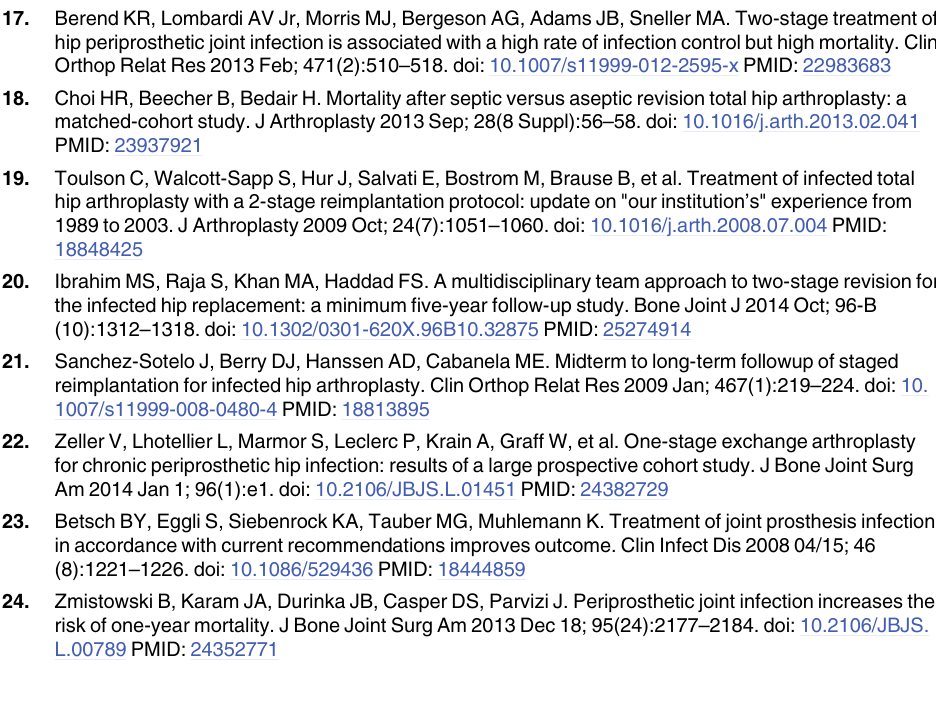
PLOS ONE | DOI:10.1371/journal.pone.0163457 September 22,